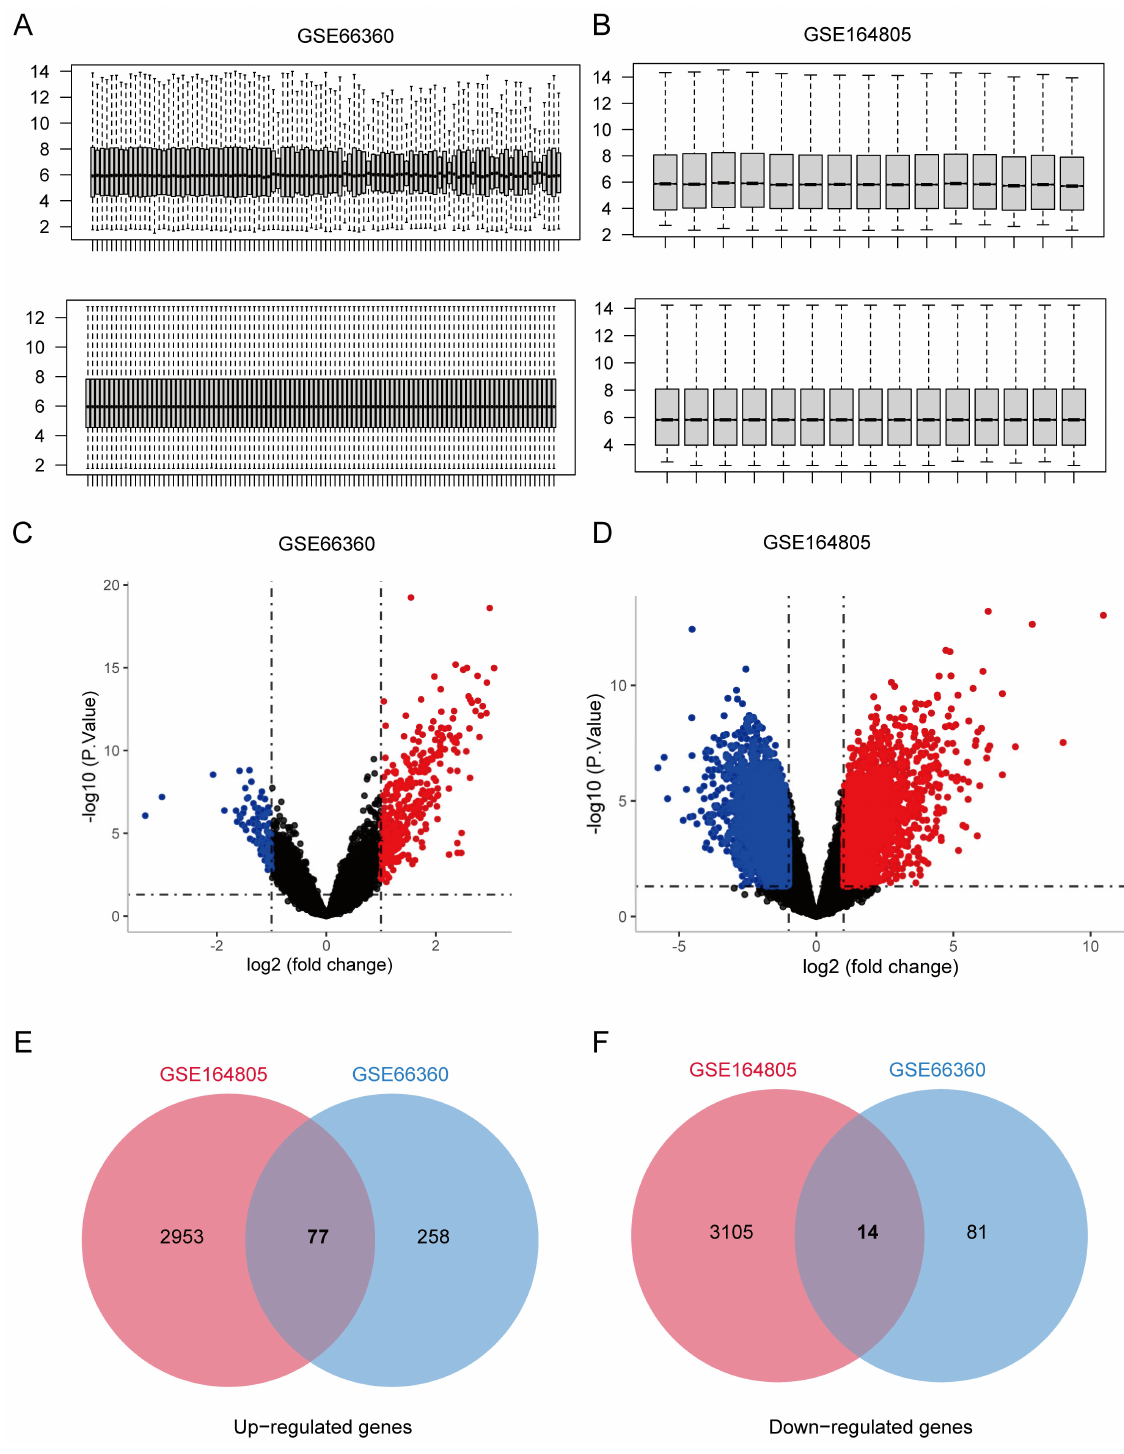
Figure 1. The shared differentially expressed genes between CVD and COVID-19. The box- plots for gene expression values before or after normalization using Limma R packages in ( A ) CVD-related GSE66360 dataset and ( B ) COVID-19-related GSE164805 dataset. Volcano plots of DEGs in ( C ) GSE66360 and ( D ) GSE164805 datasets, where genes with Padj < 0.05 and |logFC (fold change)| > 1 were considered as significant DEGs. The red dots present up-regulated genes, the green dots indicate down-regulated genes, and the black dots present non-significant genes. Venn diagrams of ( E ) up-regulated and ( F ) down-regulated DEGs in the two datasets are presented. The two datasets show an intersection of 91